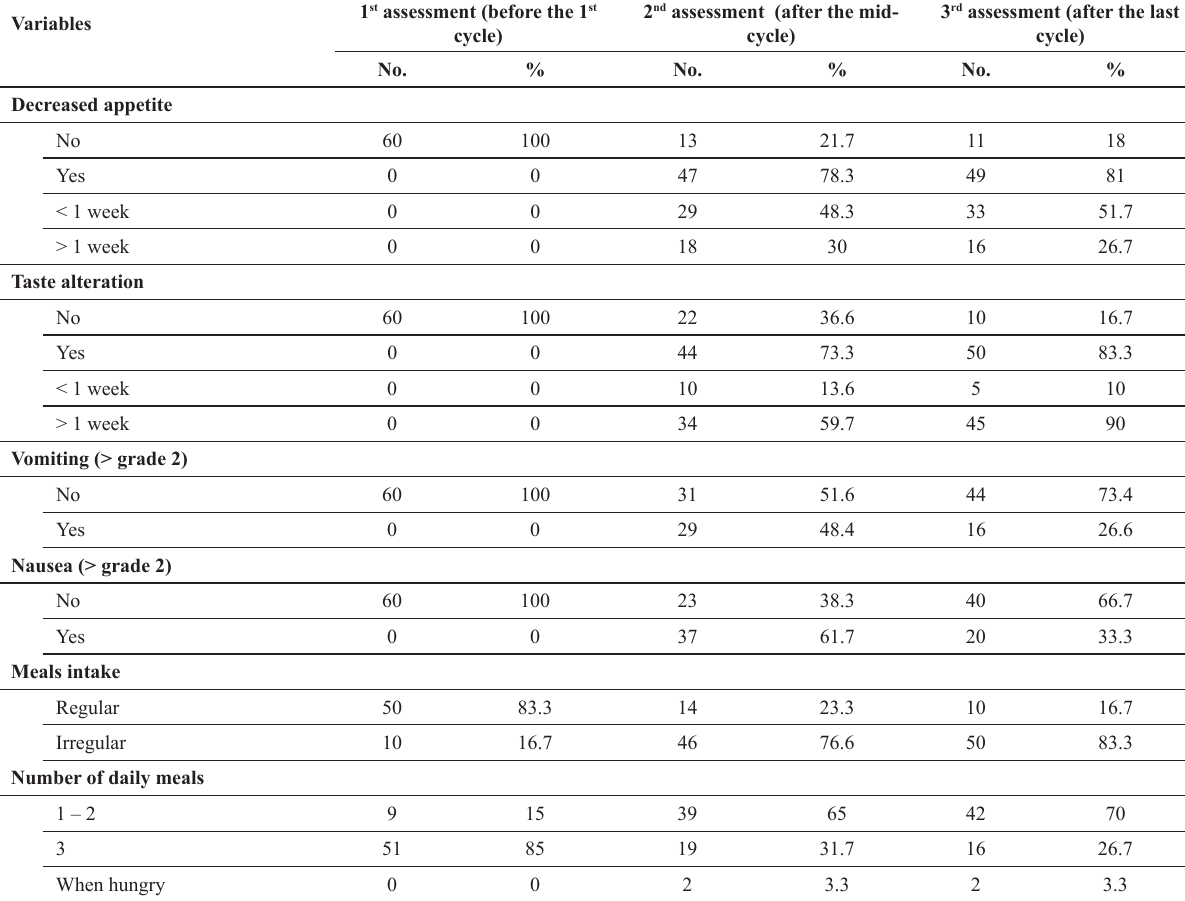
Table 5: Gastrointestinal problems and dietary intake before, during and after the course of chemotherapy.